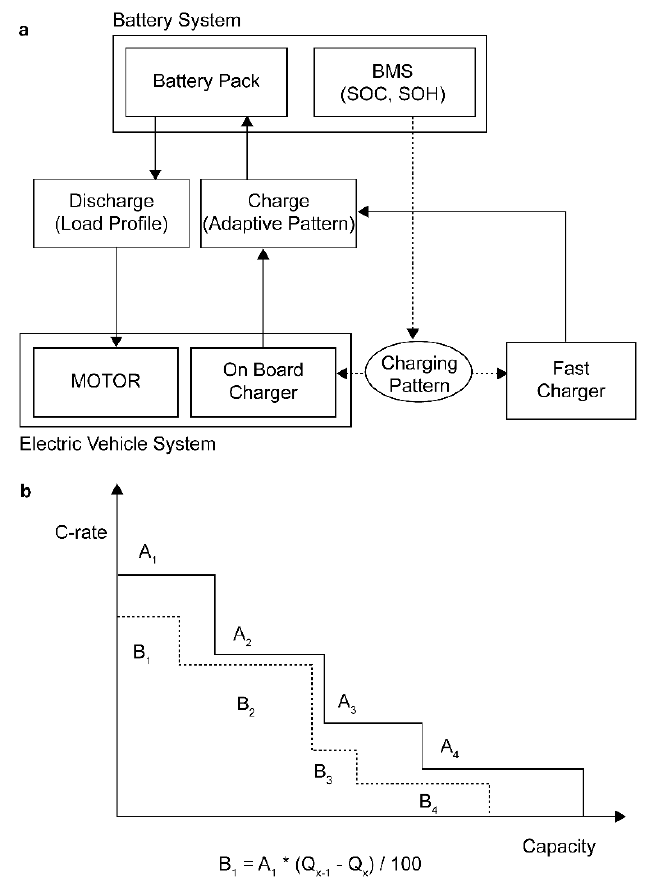
Figure 6. Adaptive rapid charging: ( a ) Battery capacity degradation tracking algorithm; and ( b ) adaptive rapid charge pattern control based on capacity degradation.